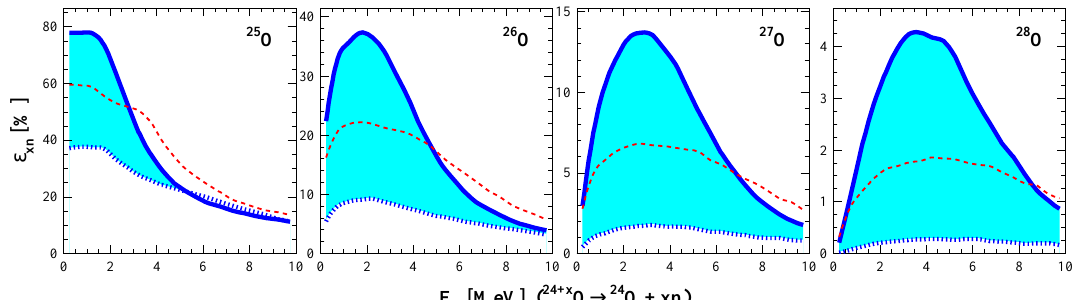
Figure 3: Simulated multi-neutron efficiency of the NEBULA array for the decay of unbound oxygen isotopes A O at 250 MeV / nucleon into 24 O + ( A − 24 ) n as a function of the decay energy. The dotted blue line corresponds to the standard two-wall con- figuration of NEBULA, the solid blue line to the EXPAND extension to four walls, and the dashed red line to the addition of four double-planes of